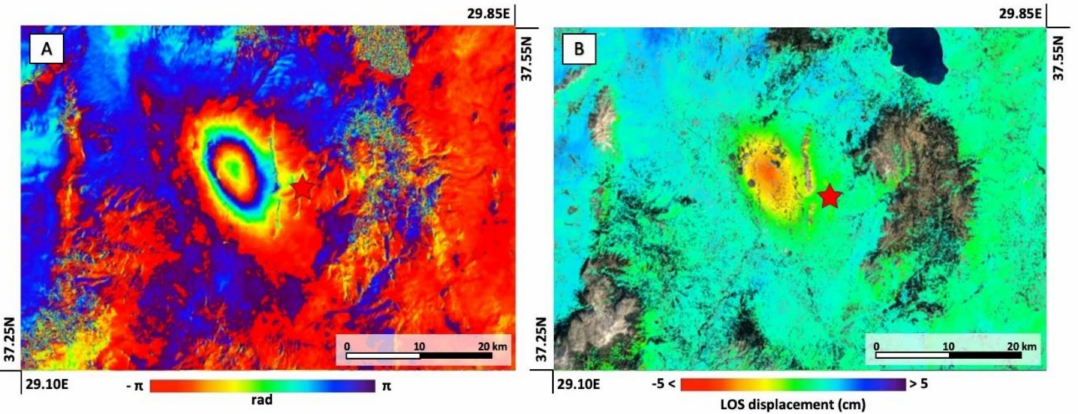
Figure 6. Sentinel-1 results relevant to the 20 March 2019 Acipayam (Turkey) seismic event. ( A ) Coseismic interferogram produced from S1 descending images (Track 138) spanning the time interval 17 March 2019–23 March 2019. ( B ) Coseismic displacement map related to the interferogram reported in ( A ). The red star identifies the epicenter of the seismic